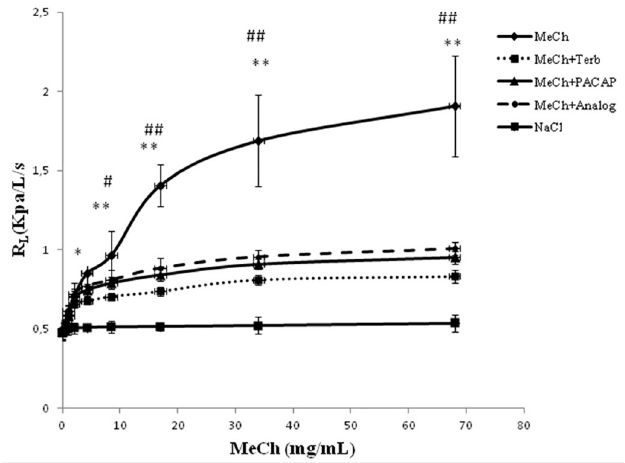
FIGURE 1 - Effect of terbutaline, PACAP38 or PACAP38 analog on lung resistances (R ) of rats challenged by metacholine L (Mech). Each value is the mean ± SD of 8 determinations. * p ≤ 0.05, ** p ≤ 0.01 compared to control; # p ≤ 0.05, ## p ≤ 0.01 compared to Terb, PACAP38 or PACAP38 analog challenged groups at the corresponding dose (Tukey’s multiple comparison post hoc